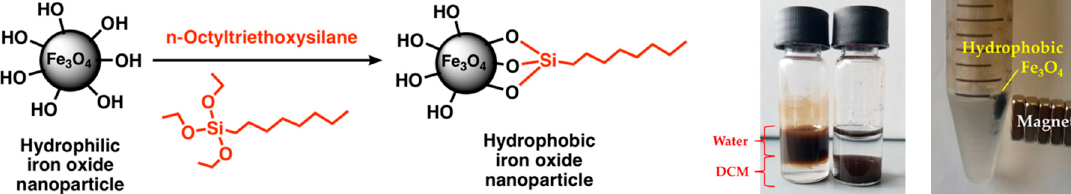
Figure 3. Surface functionalization of iron oxide nanoparticles using n-octyltriethoxysilane. (First photograph) Hydrophobic magnetite nanoparticles (NPs) phase separate into organic medium. Left: hydrophilic nanoparticles. Right: hydrophobic nanoparticles. (Second photograph) Hydrophobic Fe 3 O 4 attracted by a set of magnets.